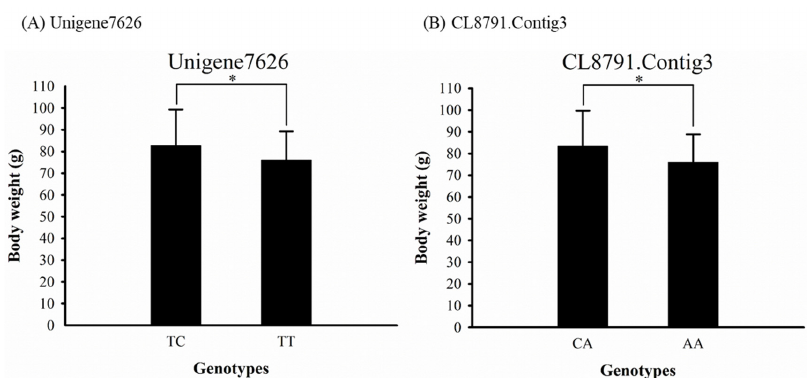
Figure 4. Number of juveniles with different genotypes at the two SNPs, Unigene7626 ( A ) and CL8791.Contig3 ( B ). The genotypes of the two SNPs were significantly different in terms of body weight based on one ‐ way ANOVA (* p < 0.05).